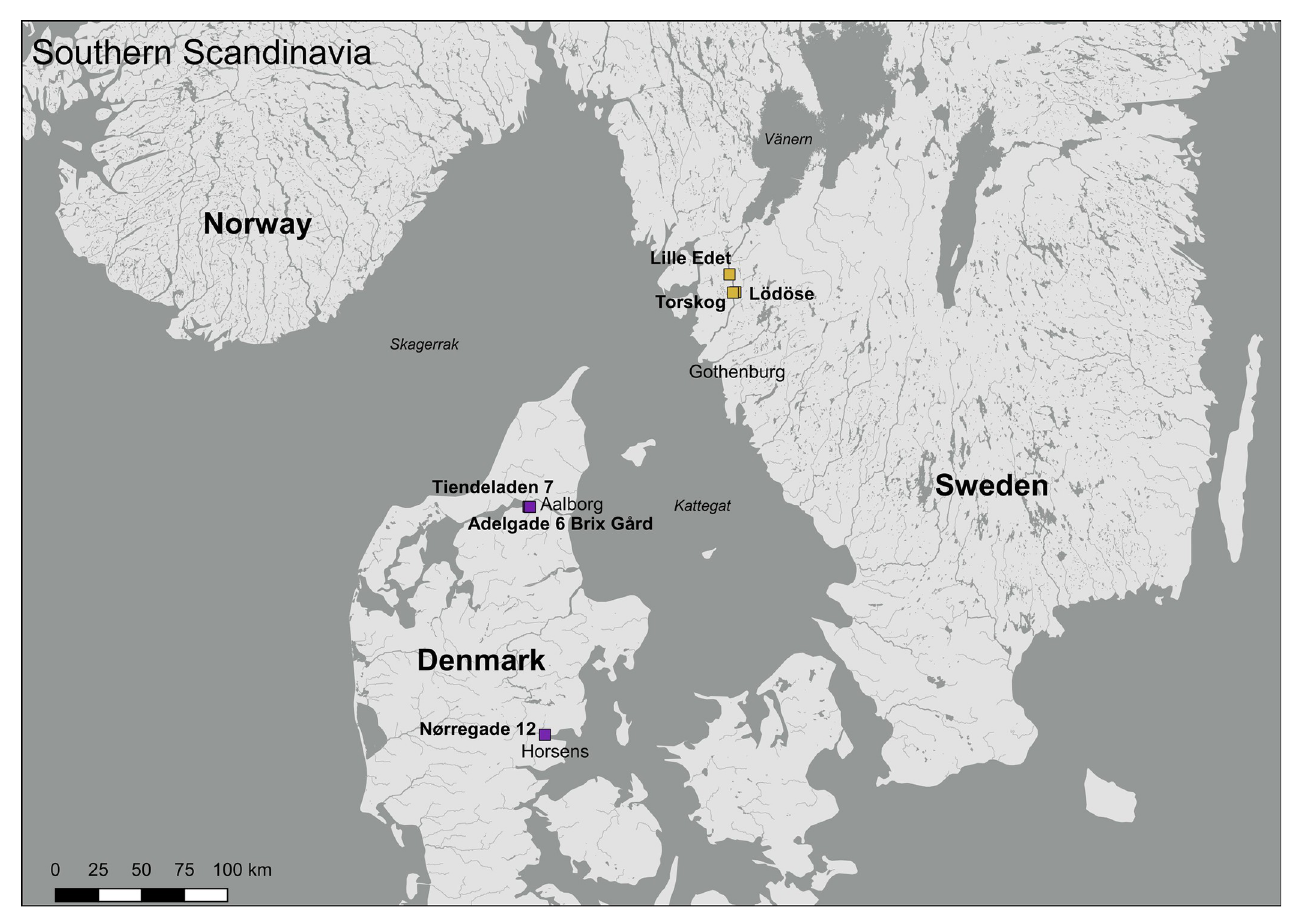
Fig 1. Map of southern Scandinavia showing the locations of the sites described in the text (baseline samples (yellow squares) and buildings (purple squares)). The background map is from Natural Earth. Free vector and raster map data @ naturalearthdata.com. Natural Earth (public domain): http://www. naturalearthdata.com. The river data is from www.hydrosheds.org (accessed March 3, 2020). The map is generated using QGIS.org, 2021. QGIS Geographic Information System. QGIS